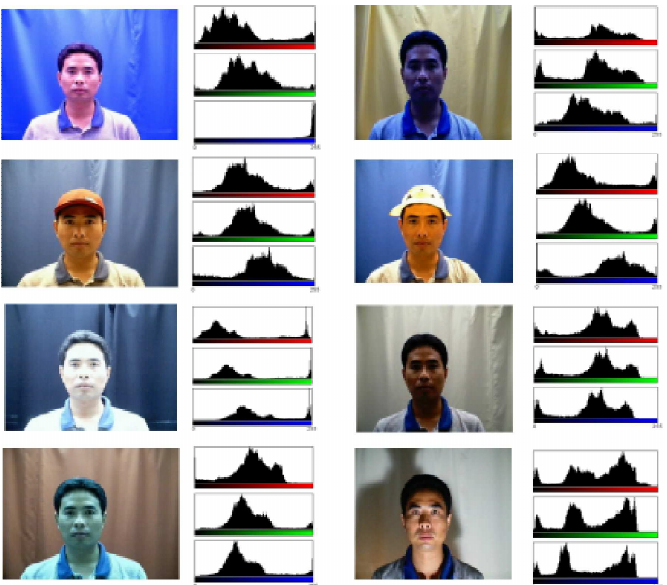
Figure 1. Faces in various illuminated scenes: the histograms indicate the large varieties for the same individual in different